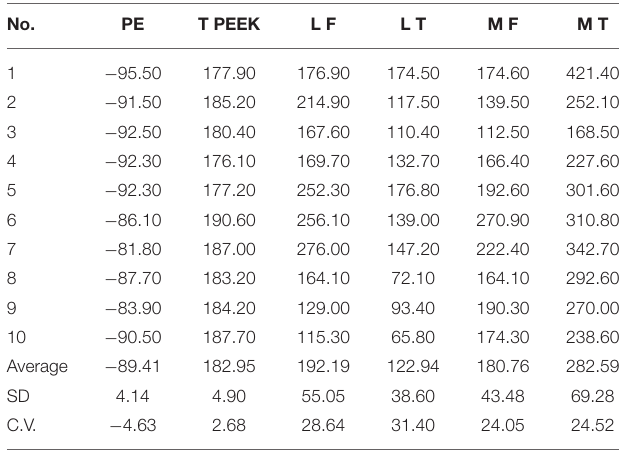
TABLE 1 | Results of HU measurements for HXLPE, PEEK, and cancellous bone (1 month post operation). No.